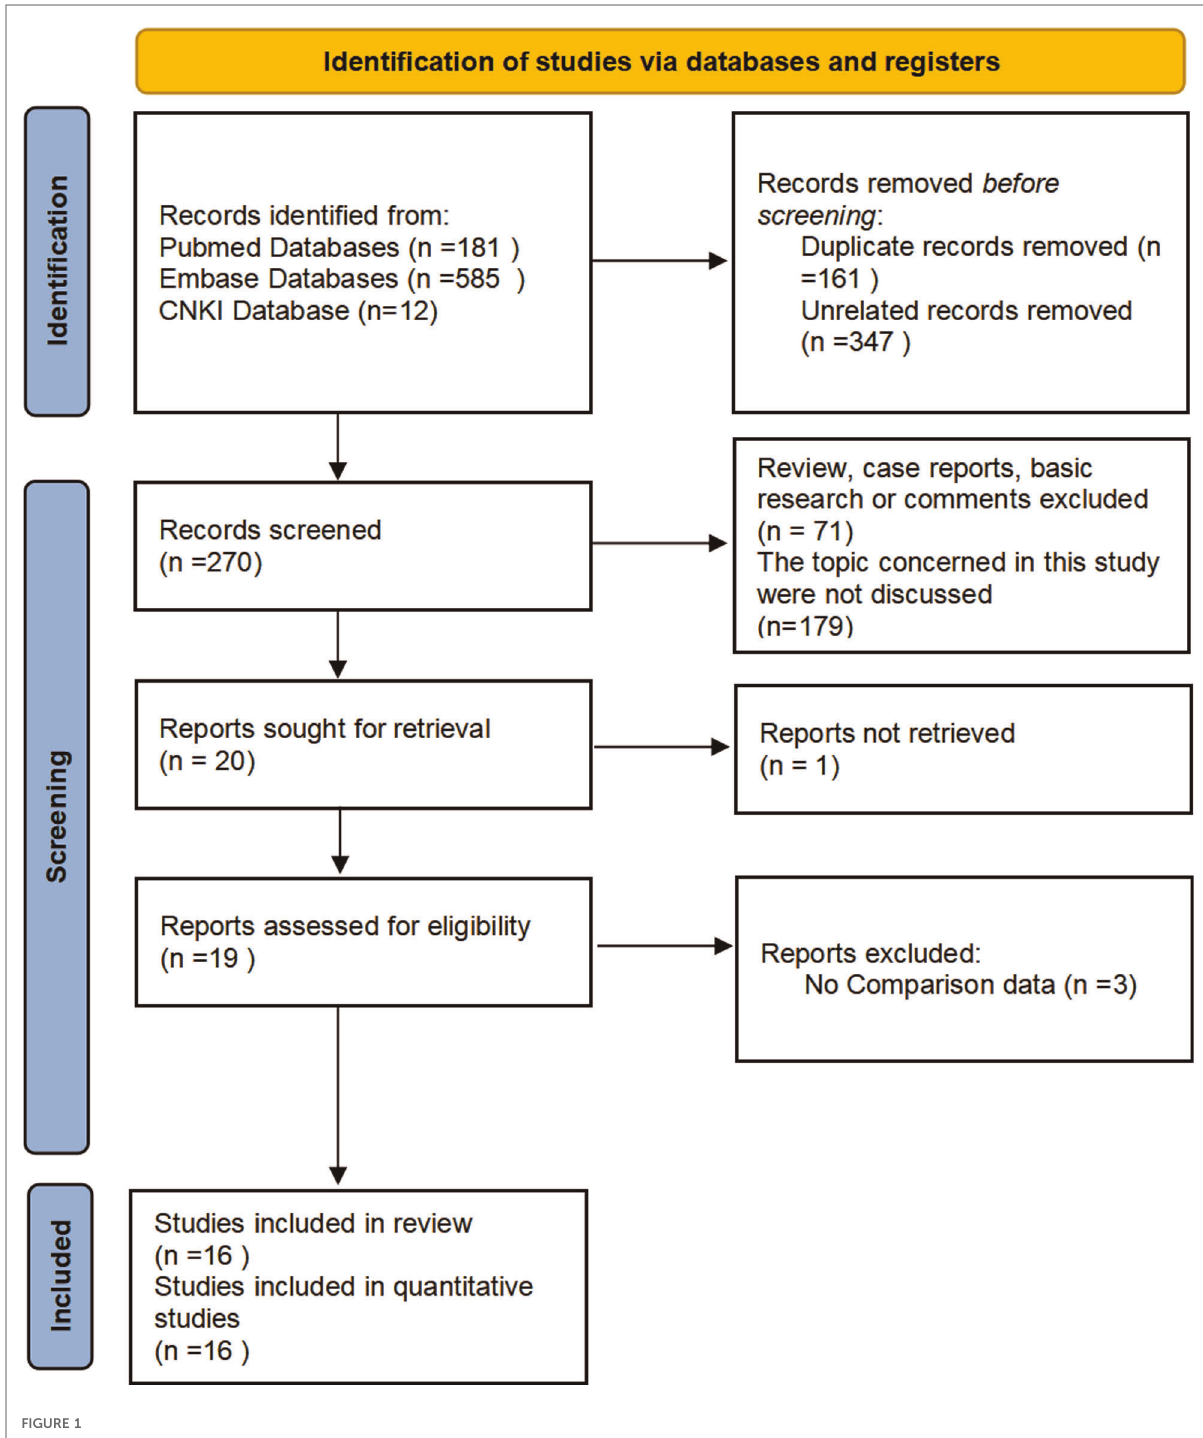
FIGURE 1 Study searching and screening fl ow